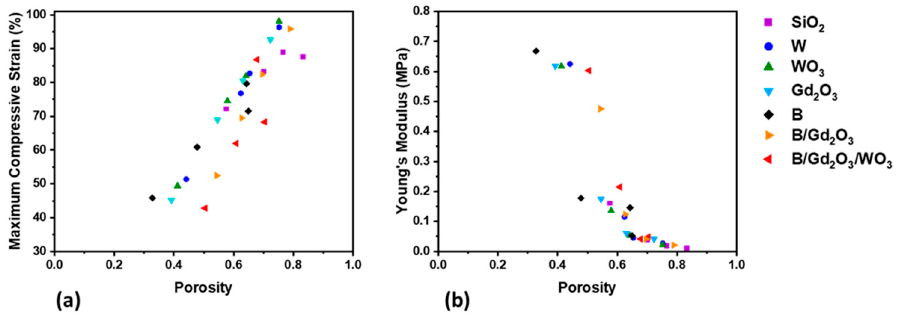
Figure 7. Mechanical properties from compression testing as functions of sample porosity: ( a ) maximum compressive strain, and ( b ) Young’s modulus.